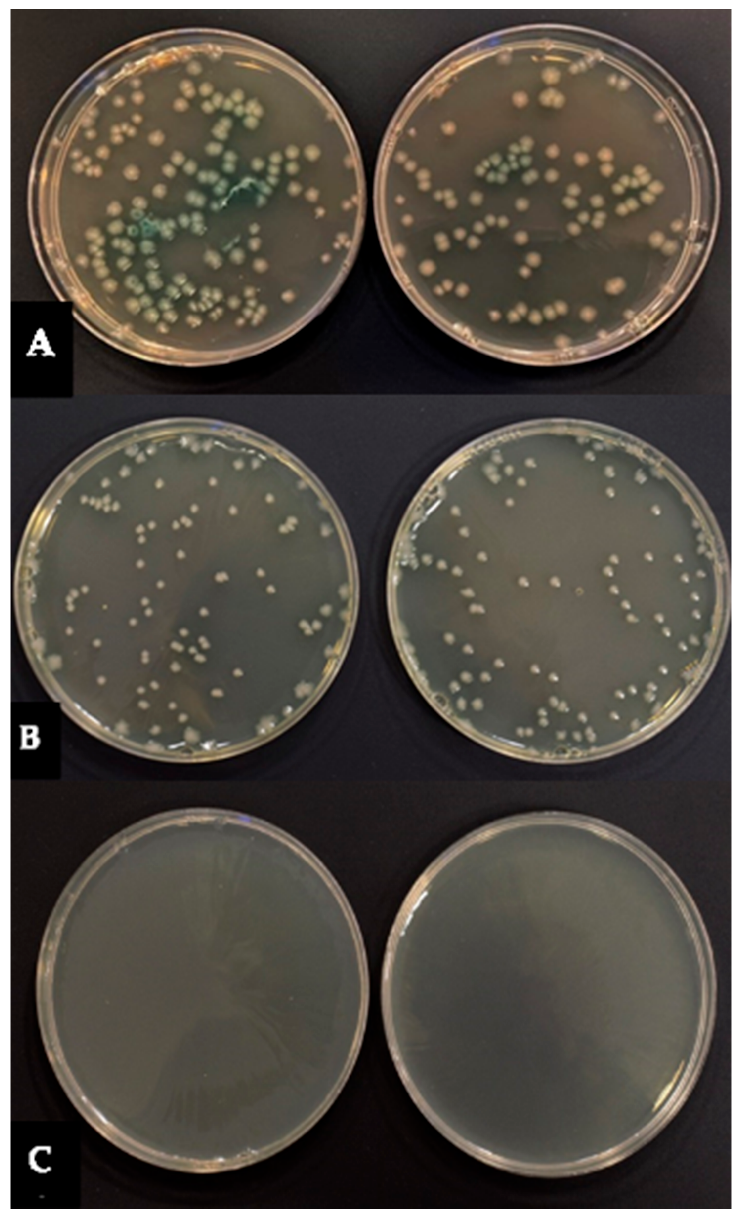
Figure 2. Photocytotoxic effect of Pc+ against P. aeruginosa through incubation and plate counting method. Representative plates with bacterial colonies of P. aeruginosa . ( A )—number of P. aeruginosa in the control sample not containing the photosensitizer and not irradiated (L- Ps-); ( B )—number of P. aeruginosa in the non-irradiated test containing the photosensitizer (dark toxicity (L- Ps+)); ( C )—number of P. aeruginosa in the irradiated test containing the photosensitizer (photocytotoxicity (light toxicity) (L+ Ps+)).